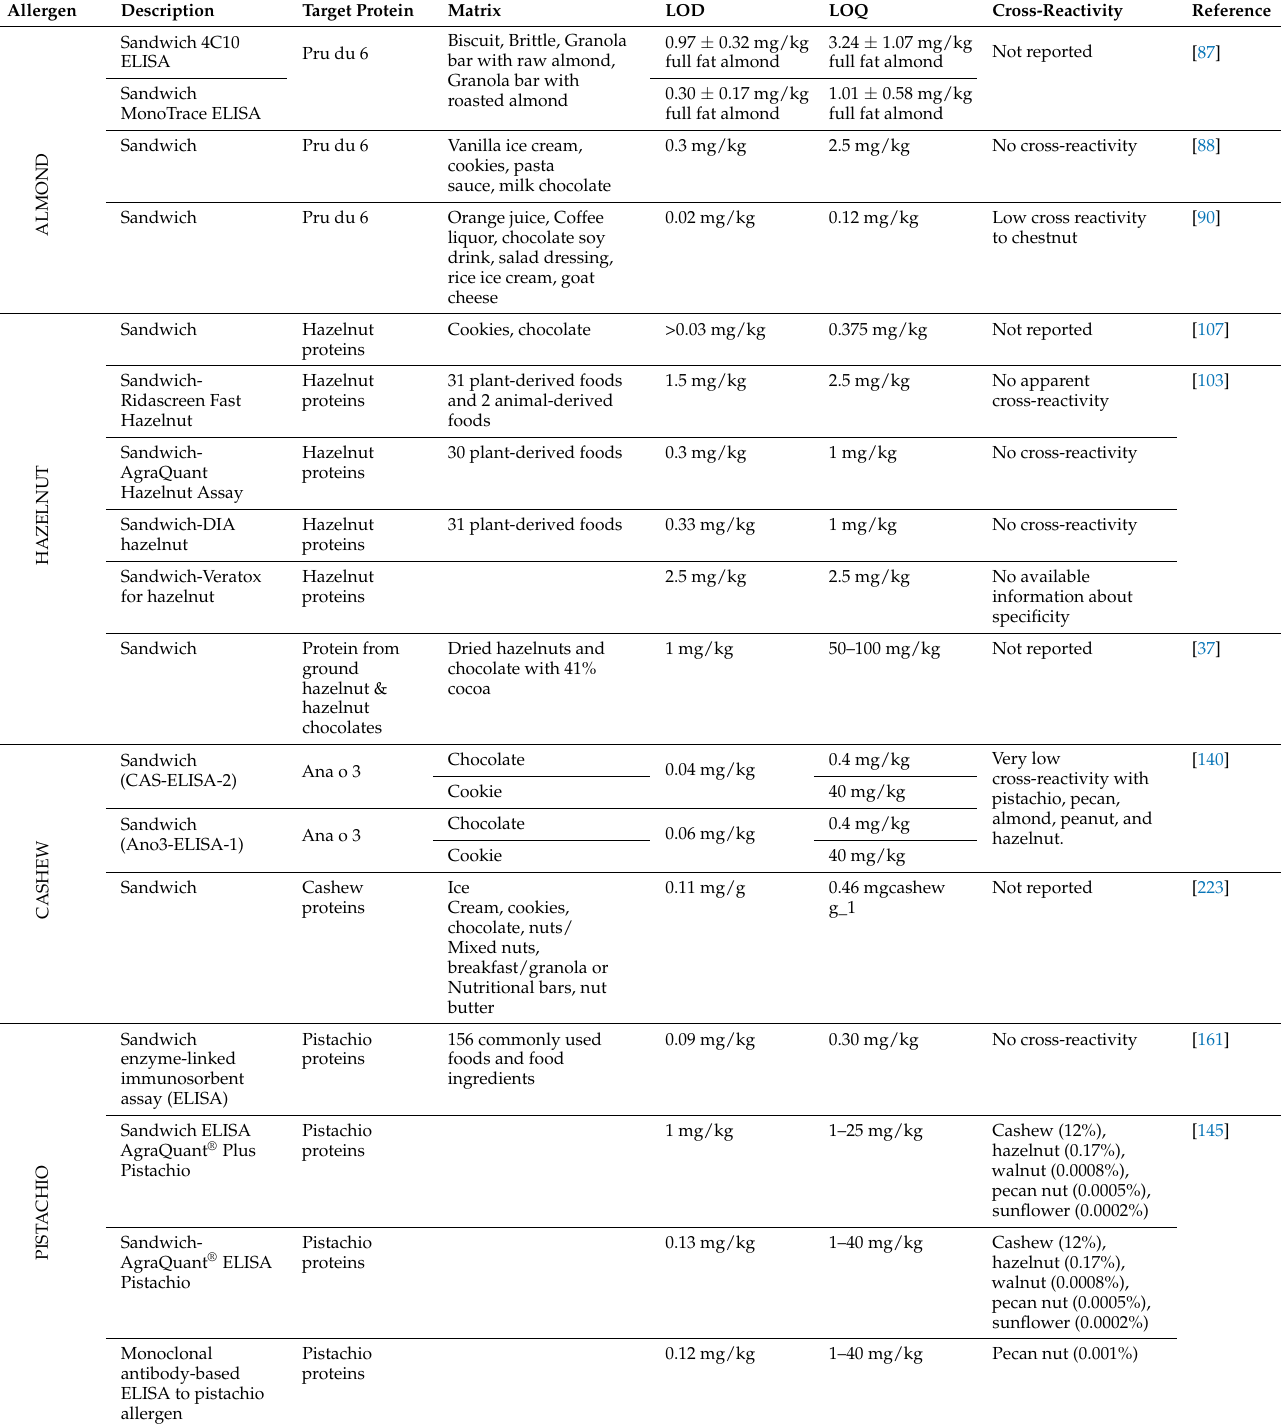
Table 1. Overview of the most recent ELISA kit developed for the detection of peanut and nuts allergens reported in